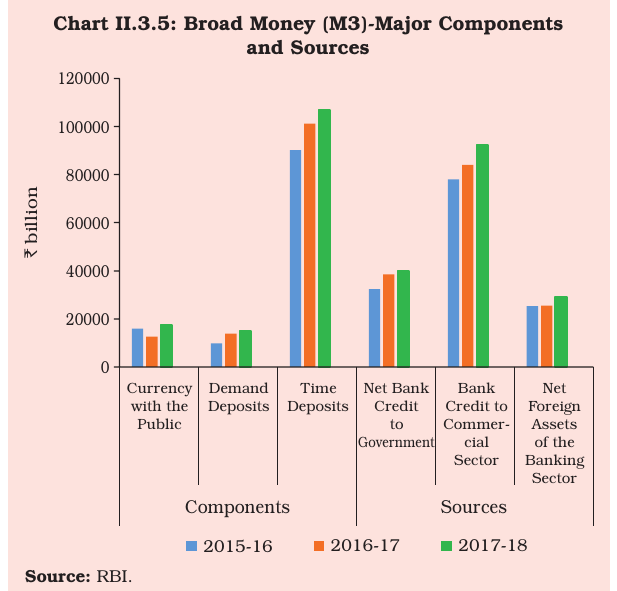
Chart II.3.5: Broad Money (M3) Major Components- and